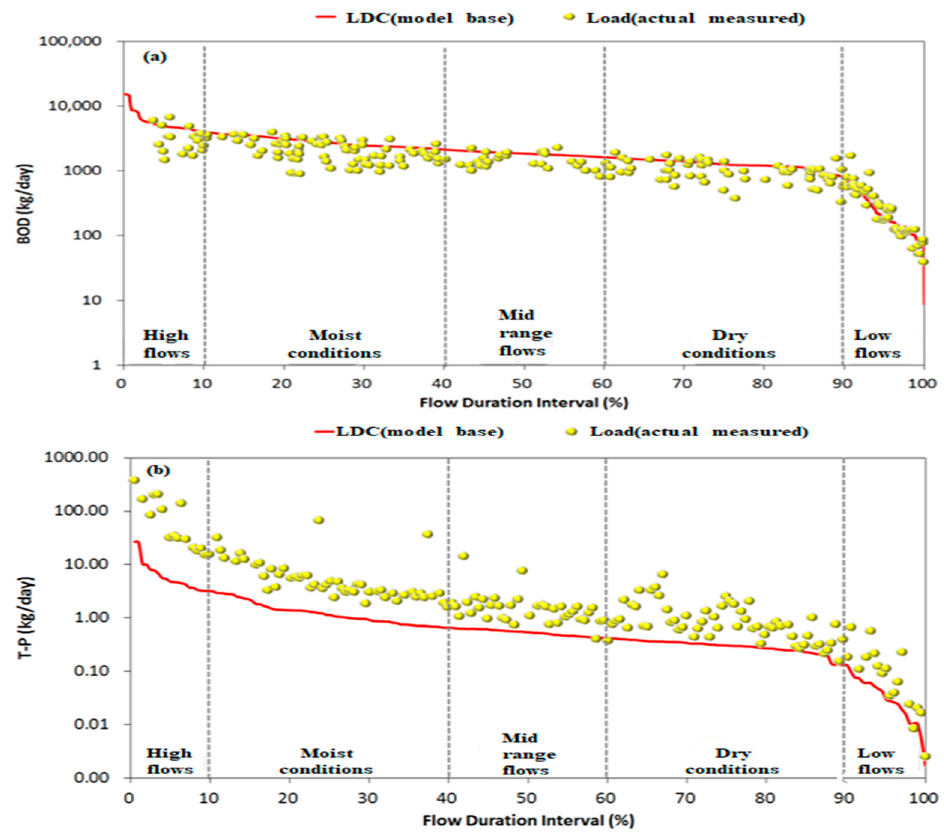
Figure 9. Example of management item selection (( a ): BOD, ( b ): TP).